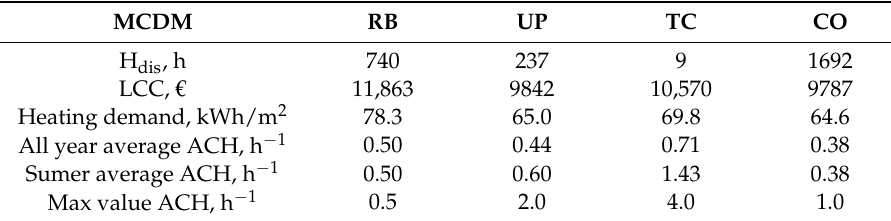
Figure 4. Pareto front for case 1 (triangle–MCDM solutions). Table 4. Optimal results for case 1.